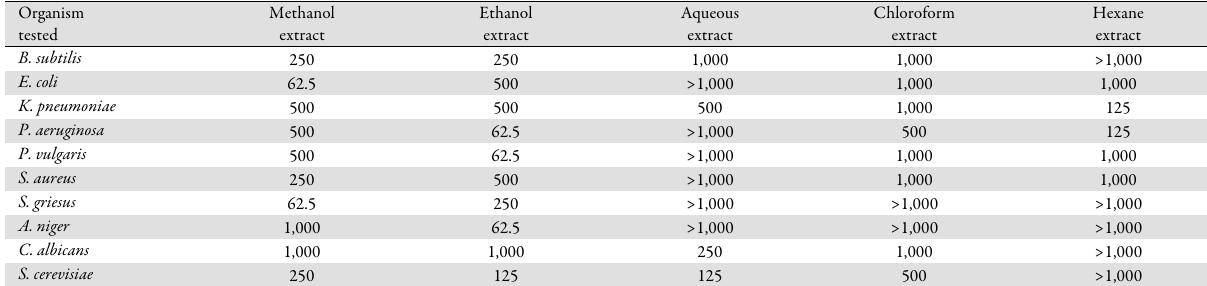
Methanol extract